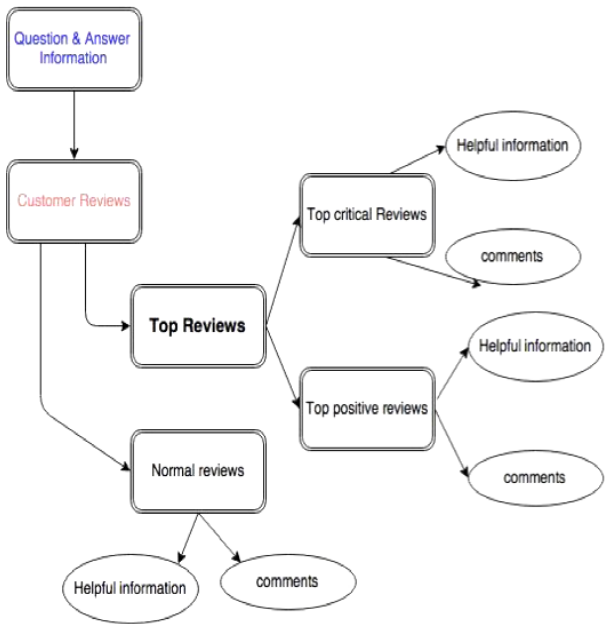
Fig. 2. The structure of customer reviews for a product on Amazon website. [Refere to the